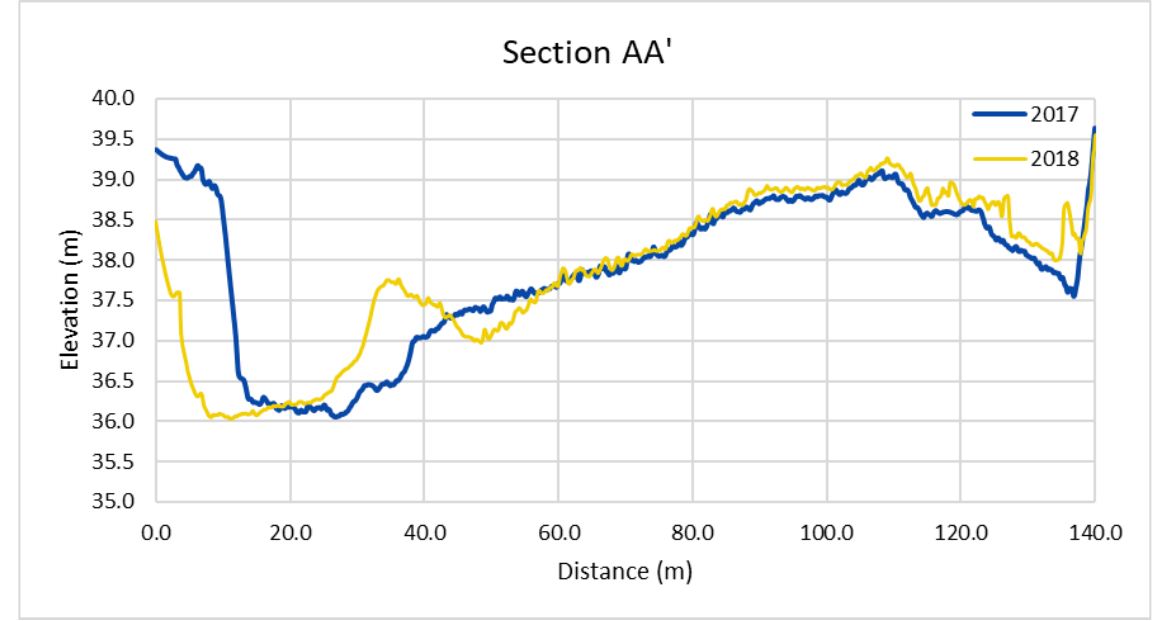
Figure 10. Section AA’ of the examined case A (Figure 9) traced on the DTMs. The representation allows for a clearer evidence of the riverbank retreat (on the left side). The central part shows the overlapping of the two DTMs; difference values are part of the error (±20 cm).